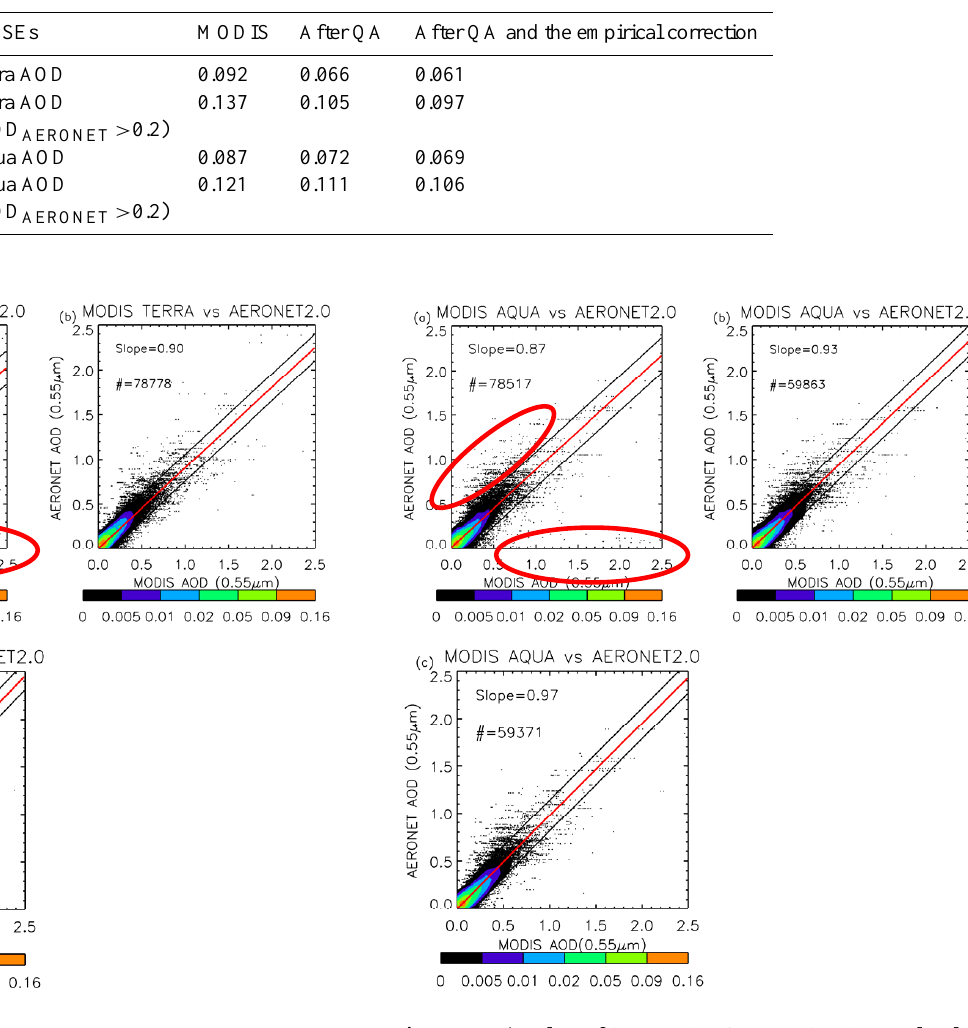
Fig. 3. Density plot of Terra MODIS versus AERONET level 2.0 AOD at 0.55µm for 2000–2008. Color contour shows the number density of data per unit plotting area. Black color indicates areas with low data density while orange indicates high data density re- gions. The red line is the linear regression line for all data and the black lines are the 1.0 standard deviation line of the red line. The red circles highlight outliers that were removed after the QA proce- dures. (a) for the MODIS C5 aerosol products. (b) for the aerosol data that passed the quality assurance filters. (c) for the newly gen- erated level 3 MODIS AOD.